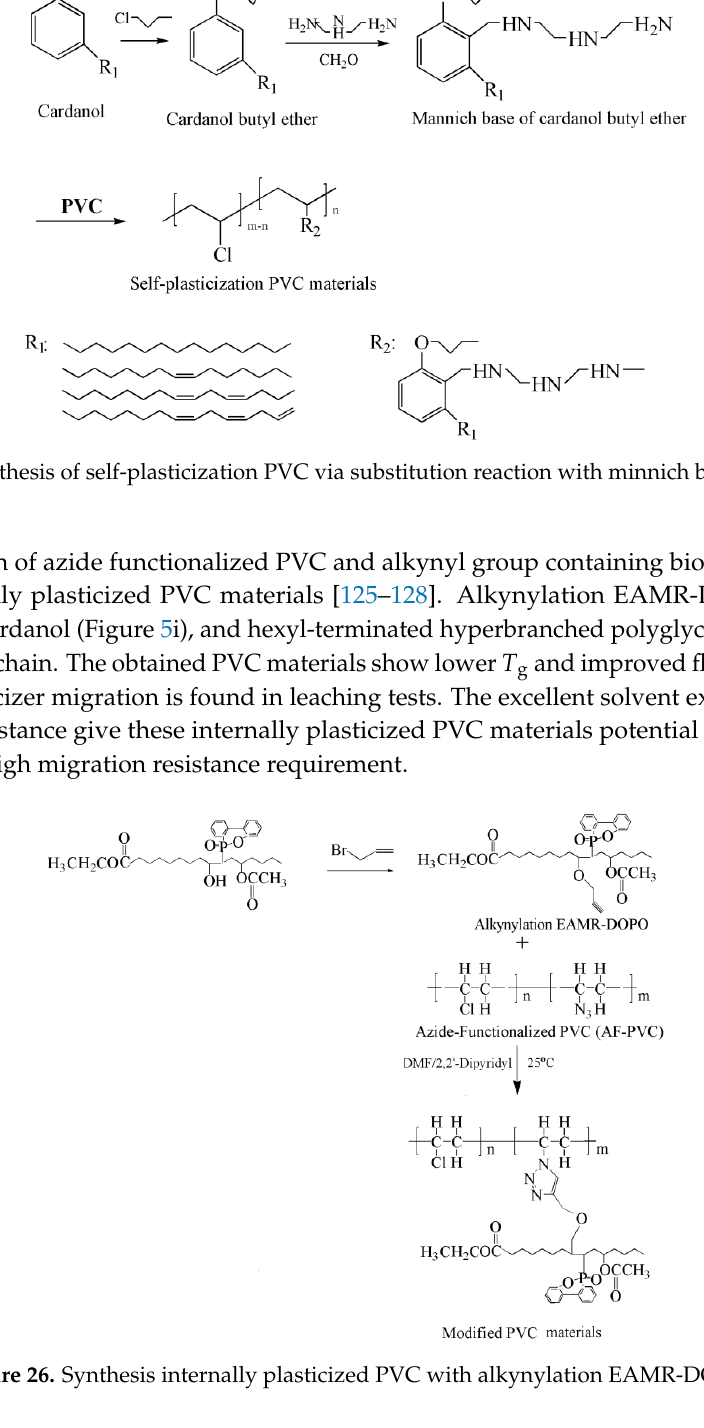
Figure 27. Synthesis of hexyl-terminated hyperbranched polyglycerol. 3. Conclusions Biomass resources have been frequently used to produce PVC plasticizers as low-cost raw materials. Bio-based plasticizers designed for different application are mostly based on chemical structure of biomass resources. C ardanol is a promising alternative to traditional petrochemical- based o -phthalate plasticizers due to its benzene ring structure and active hydroxyl group. Vegetable oil contains flexible long fatty acid chains and rich unsaturated bonds and can be used to produce epoxy plasticizer. Epoxidized soybean oil (ESO) has been industrialized and used as primary plasticizer in food packing materials. Vegetable oil-based flame-retardant plasticizers provide rich carbon combined with flame-retardant elements to improve flame retardancy of PVC product by promoting the formation of char residue. Cardanol and vegetable oil have been the two most important biomass feedstocks for producing plasticizers. Internally plasticized strategy produces